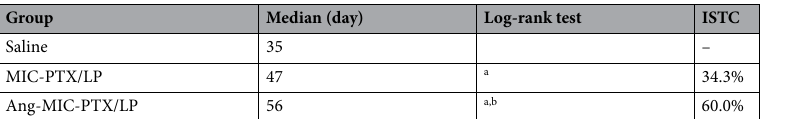
Table 1. The median survival time of tumor-bearing mice treated with different preparation. a P < 0.05, b P < 0.05, compared with saline and MIC-PTX/LP, respectively. The increases in survival times (%) were compared to control